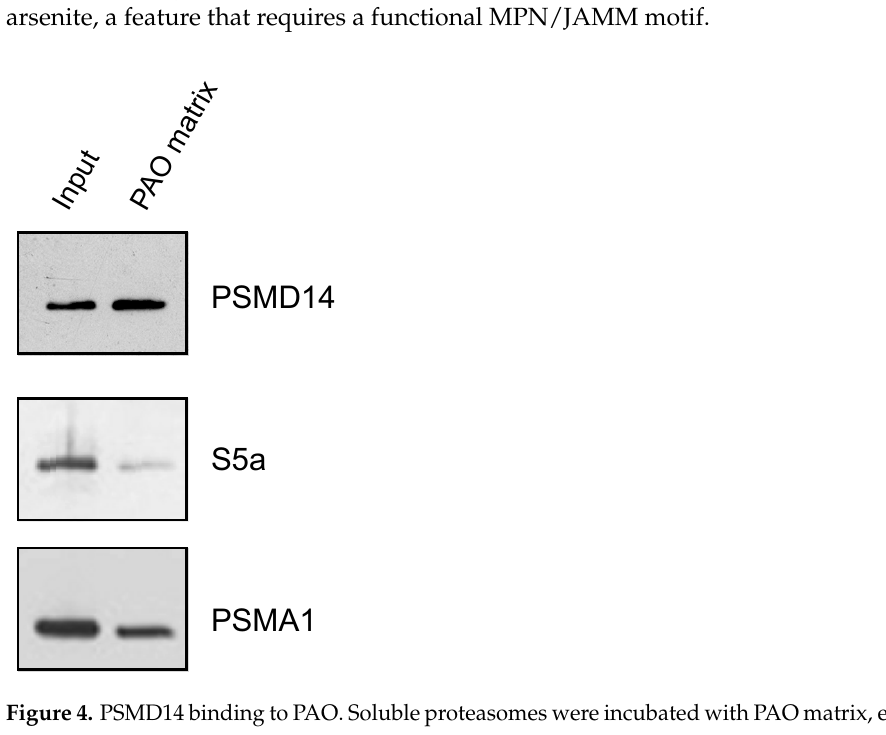
Figure 4. PSMD14 binding to PAO. Soluble proteasomes were incubated with PAO matrix, extensively washed and PSMD14, 19S (S5a), and 20S (PSMA1) content revealed by immunoblot.